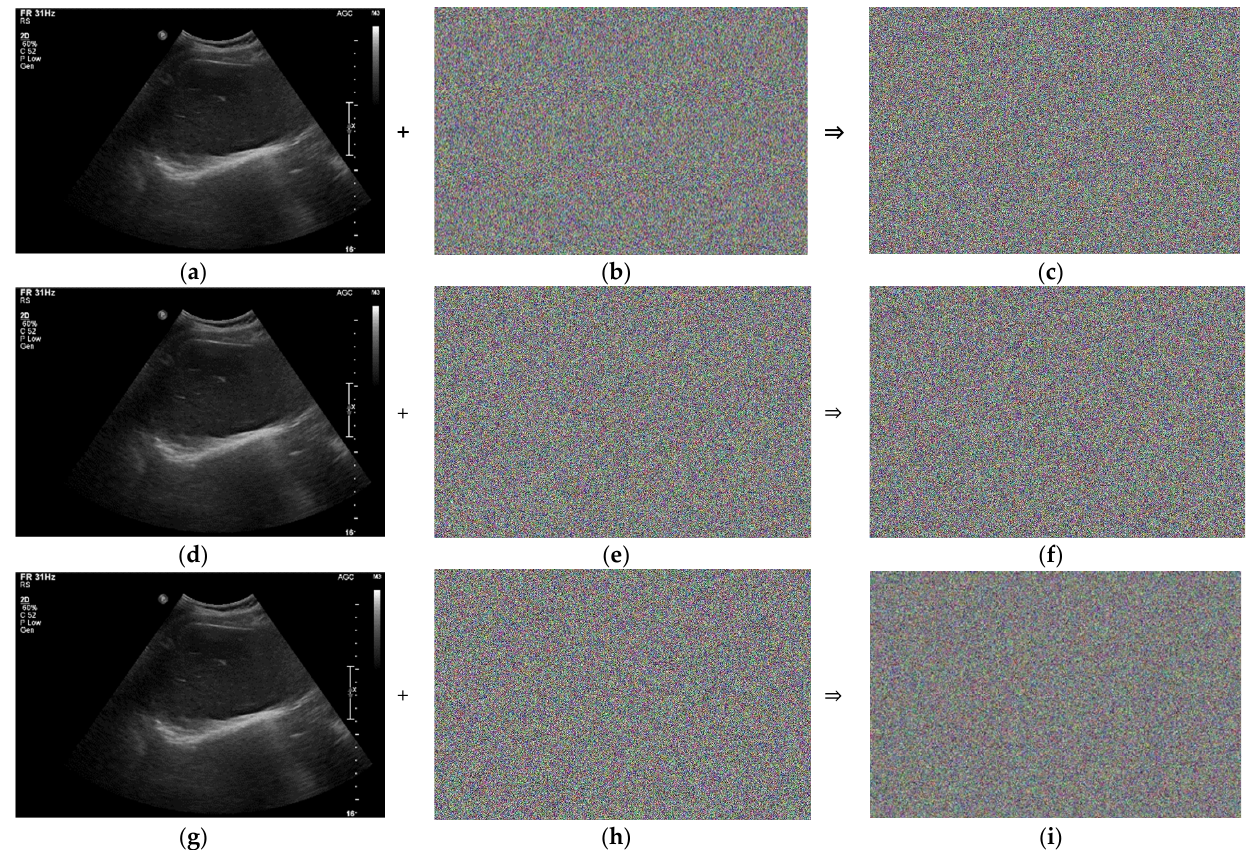
Figure 10. Randomization of abdomen phantom image: ( a ) ultrasound image; ( b ) 1000 × 663 random-bit generation visualization image; ( c ) randomized ultrasound image for dx = 0.1156 rad; ( d ) ultrasound image; ( e ) 1000 × 663 random-bit generation visualization image; ( f ) randomized ultrasound image for dx = 0.2312 rad; ( g ) ultrasound image; ( h ) 1000 × 663 random-bit generation visualization image; and ( i ) randomized ultrasound image for dx = 1.156 rad.